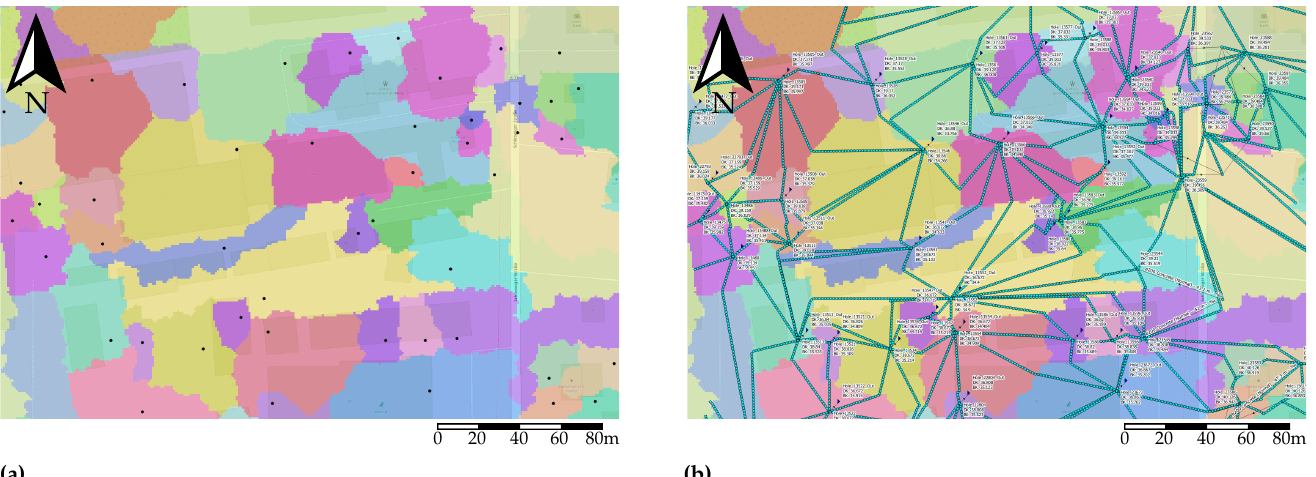
Figure 5. Illustration of the identified subareas for the extraction marked in Figure 4 with a depression threshold of 10cm. ( a ) Identified subareas (colored) and corresponding subarea center points (black dots). ( b ) Overflow interconnections (marked with blue dots) of the identified